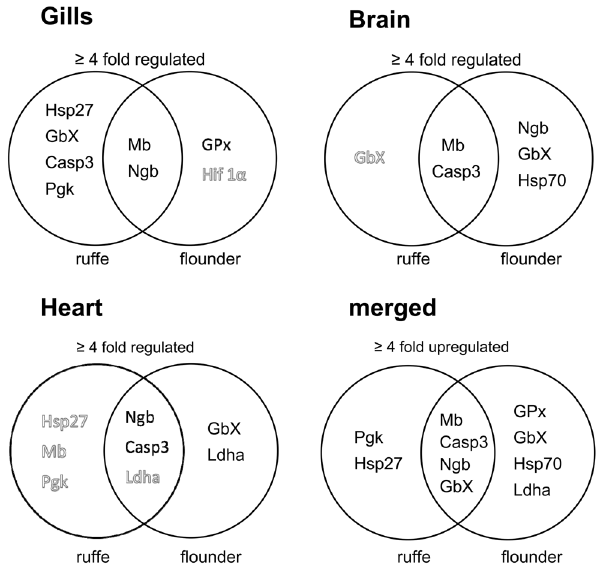
Figure 5. Venn diagram of expression changes in different tissues of ruffe and flounder. Black letters indicate genes that are upregulated and white letters indicate genes that are downregulated. Merged Venn diagram shows an overview of genes regulated more than fourfold in an overall comparison of the collected data.